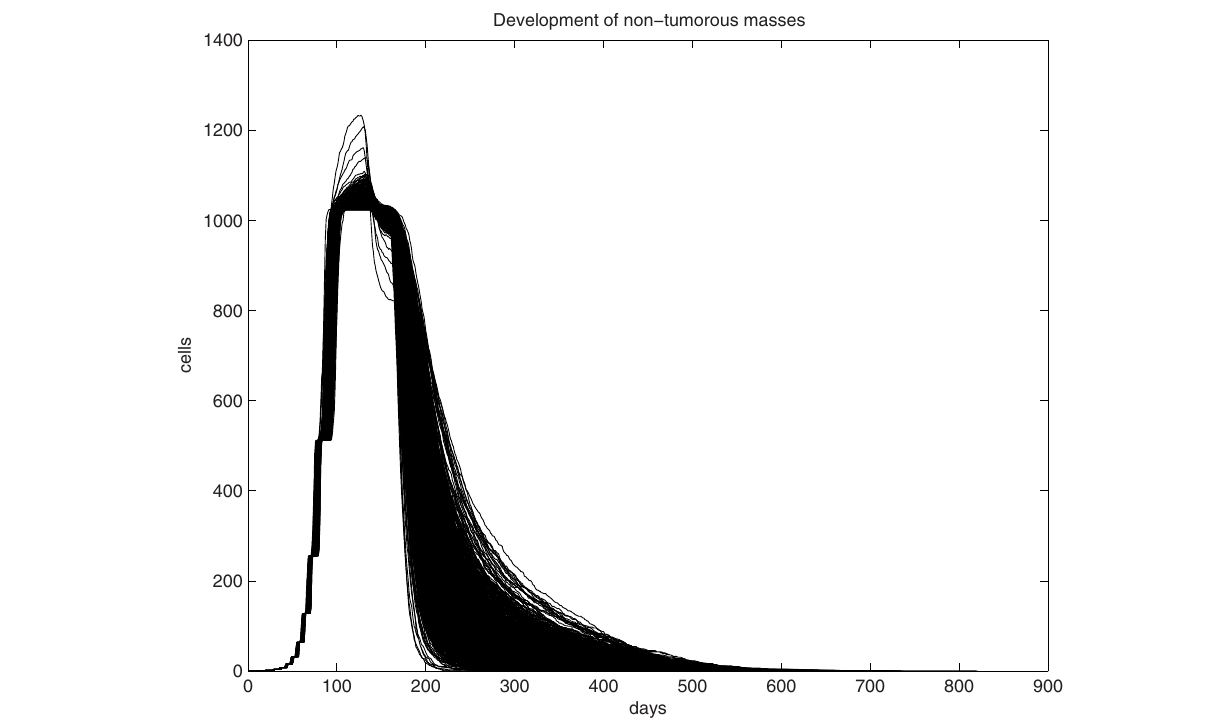
Frontiers in Oncology | Molecular and Cellular